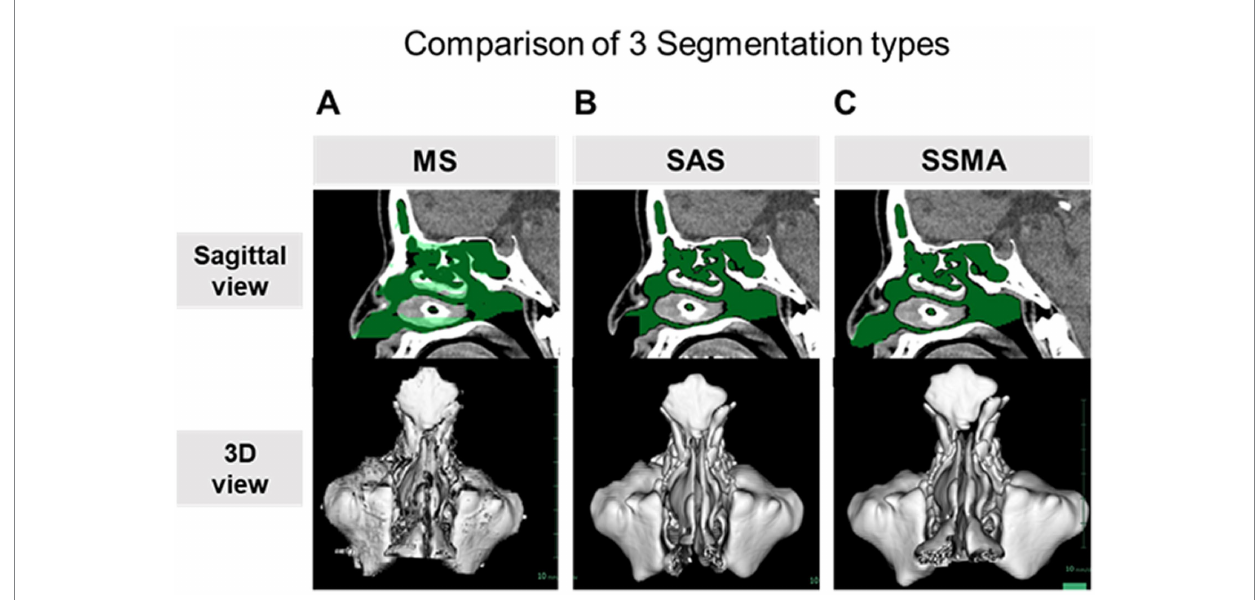
FIGURE 2 Comparison of the three surgical simulation methods. The extracted areas (green) in the nasal cavity and paranasal sinuses in the sagittal section (upper panel) and 3D models (lower panel) using the MS (A) , SAS (B) , and SSMA (C) methods. MS, manual segmentation; SAS, semiauto segmentation; and SSMA, semiautomatic segmentation with manual